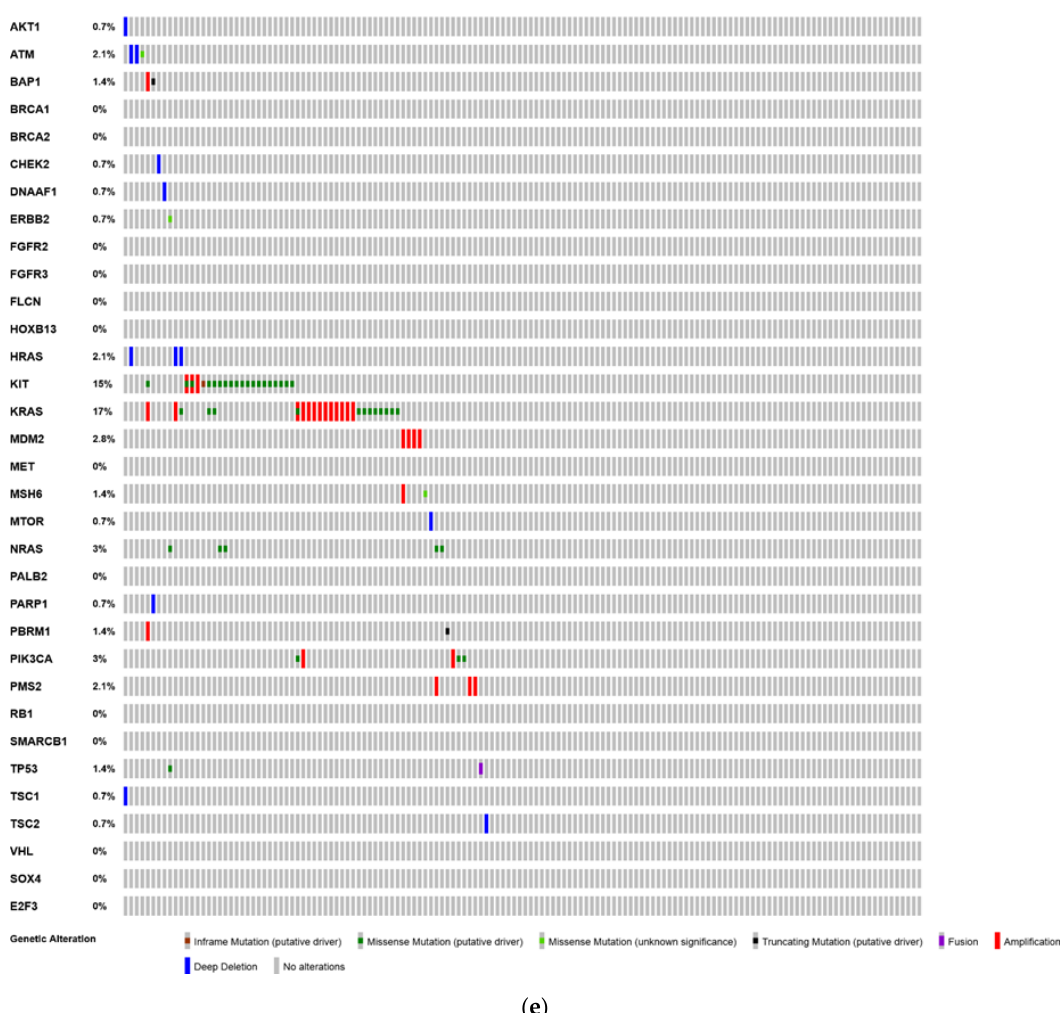
Figure 2. The Cancer Genome Atlas (TCGA) figure was generated to show copy number alterations, and mutations in selected genes. The figure panel was created using the cBioPortal [81] for the bladder, kidney (papillary and clear cell), bladder urothelial, and prostate data set available on the portal. Deep deletion denotes a deep copy number loss, potentially a homozygous deletion. Amplification denotes a high-level, often focal, copy number gain of multiple copies. Deep deletions and amplification are considered more biologically relevant than shallow deletions (which are often heterozygous) and low-level copy number gains. ( a ). clear cell renal cell carcinoma TCGA mutational landscape. ( b ). papillary renal cell carcinoma TCGA mutational landscape. ( c ). Bladder Urothelial Carcinoma TCGA mutational landscape. ( d ). Prostate adenocarcinoma TCGA mutational landscape. ( e ). Testicular cancer TCGA mutational landscape .